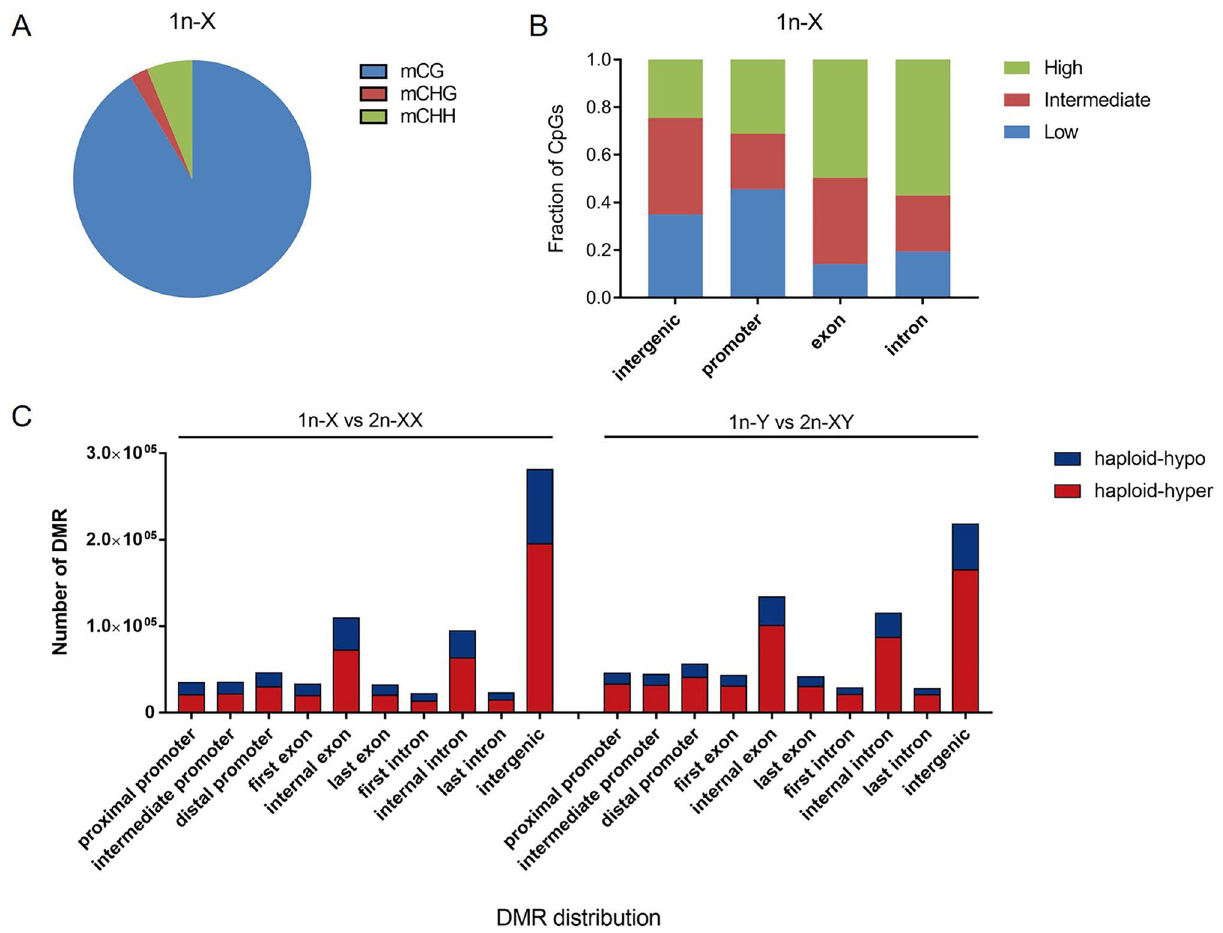
Figure 2. DNA methylation of haploid and diploid tiger pufferfish ( T. rubripes ). ( A ) Percentages of mCs in the mCG, mCHG and mCHH contexts (1n-X was shown). ( B ) Methylation level of genome regions (1n-X was shown). ( C ) Distribution of differentially methylated regions (DMRs) across the